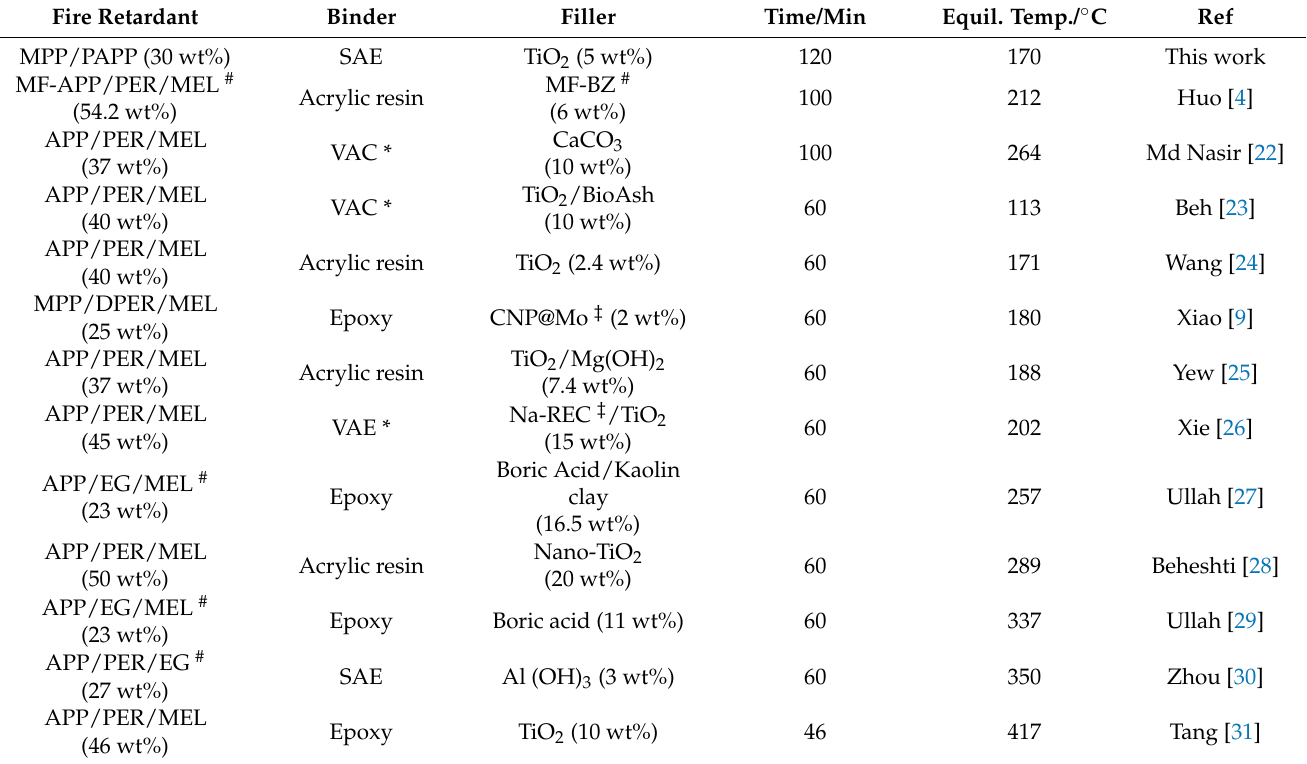
Table 2. Comparison of fire performances of as-designed fire retardant ICs for structural steel with previous